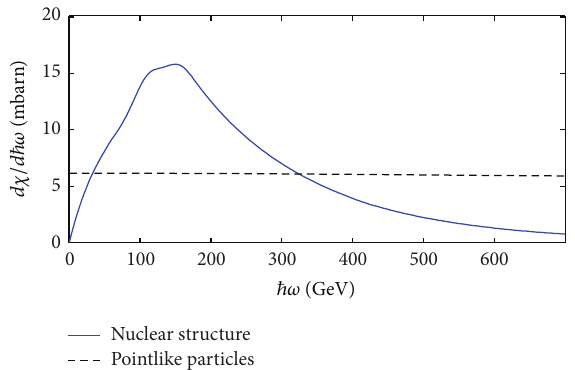
Figure 2: The same as Figure 1 except for the projectile which is here Ar-40.